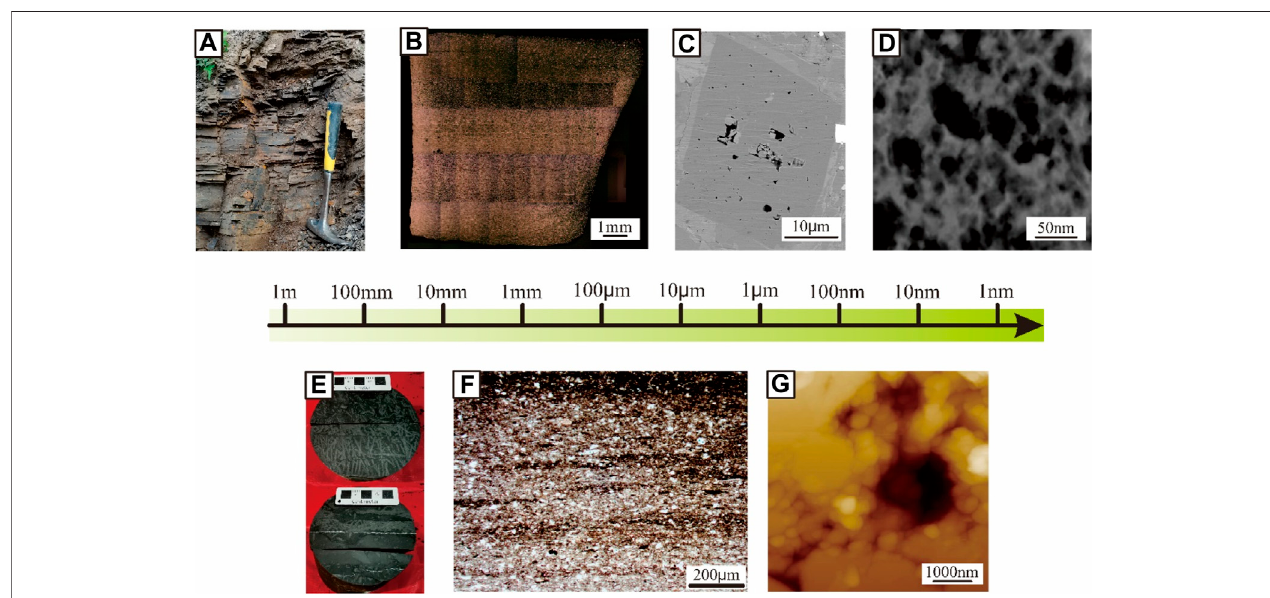
FIGURE 1 | Microscopic characteristics of shale at various scales. (A) XHY-1 shale outcrop of the Xiamaling Formation in the Zhangjiakou section; (B) Re fl ected lightimageofargonionpolishedshale(PS1-2,WufengFormation,5964.5 m); (C) FESEMimageofargonionpolishedshale(N228-14,LongmaxiFormation,3,377.9 m); (D) Scanningtransmissionelectron microscopyimageofkerogen fromtheBarnettshalesample(Curtisetal.,2011); (E) PhotosofshalecoresofLongmaxiFormationin the Sichuan Basin (DY5-49, 3,811.5 m); (F) Single polarized light image of Longmaxi Formation shale in Yanjin (N228-1, 3,365.1 m); and (G) Atomic force microscopy images of micropores in polished shale (JY4-05, Wufeng Formation, 2,591.7 m).